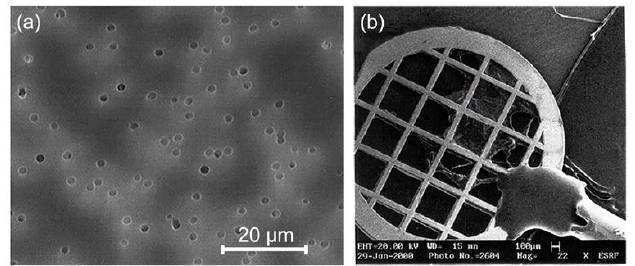
Figure 19. ( a ) SEM micrograph of a section of the investigated polymer-dispersed liquid crystal (PDLC) sample; ( b ) PDLC film on an electron microscopy copper grid.